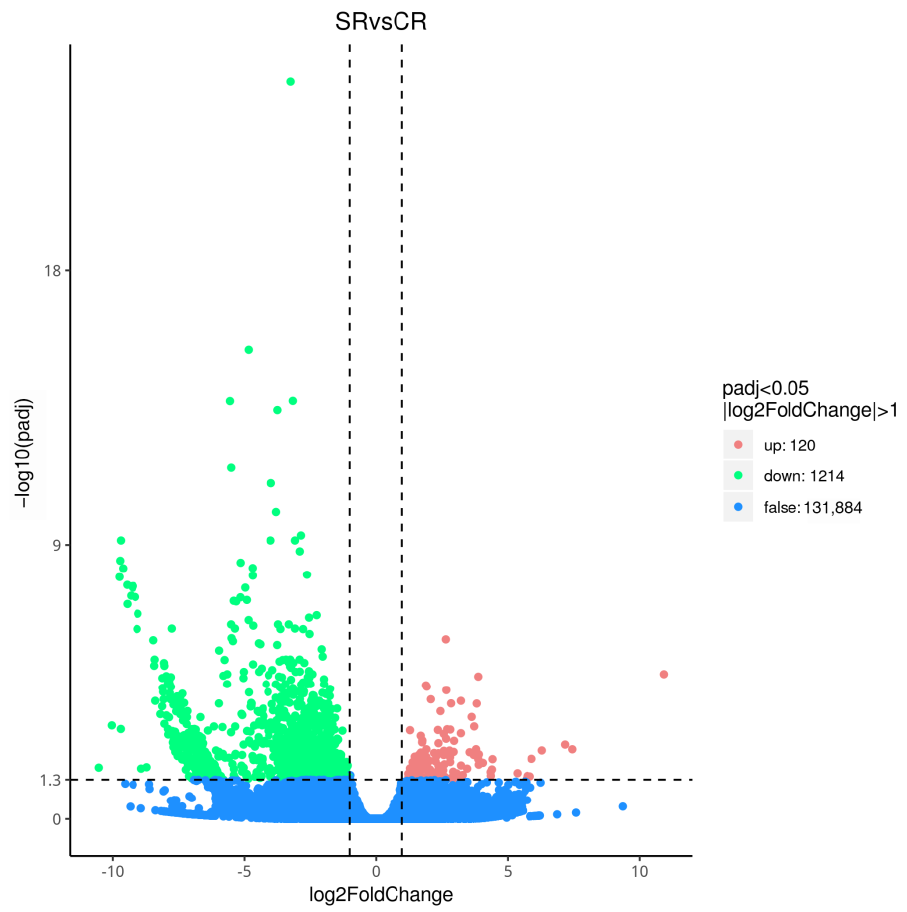
Figure 2. Volcano plot showing differentially expressed genes in water lily roots under control vs. 150 mM NaCl conditions.